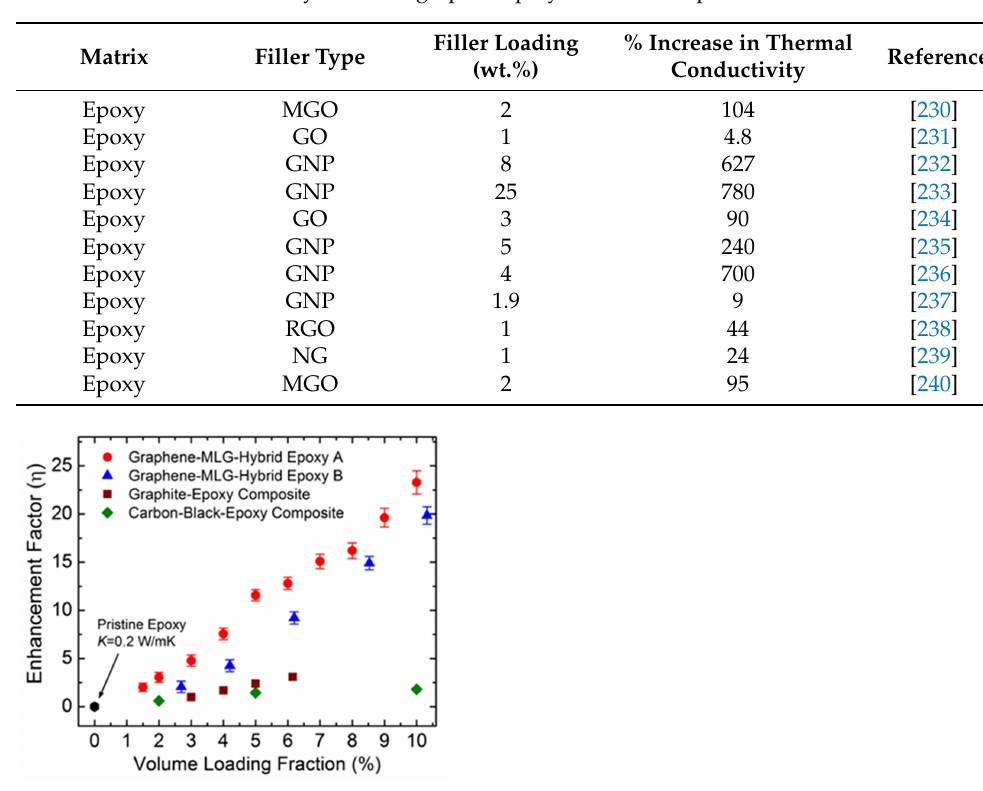
Figure 20. Thermal conductivity enrichment in the graphene–epoxy nanocomposite. ( a ) Thermal conductivity enrichment factor as a fraction of the filler volume loading fraction [220]. Reproduced with permission from the American Chemical Society (ACS).